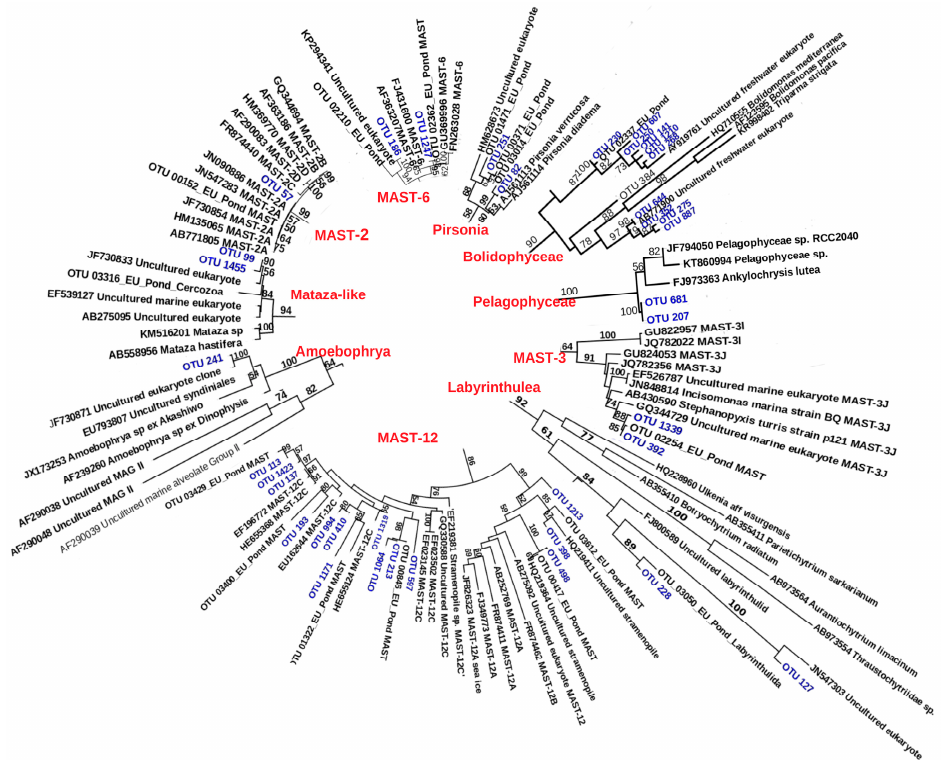
Figure 4. Sections of Maximum Likelihood (ML) trees representing clades that are known mostly from marine waters and that include Baikal OTUs (in blue) (full versions of the trees are included in Supplementary Figures S2, S3, S4, S5). Numbers next to branches indicate bootstrap support.